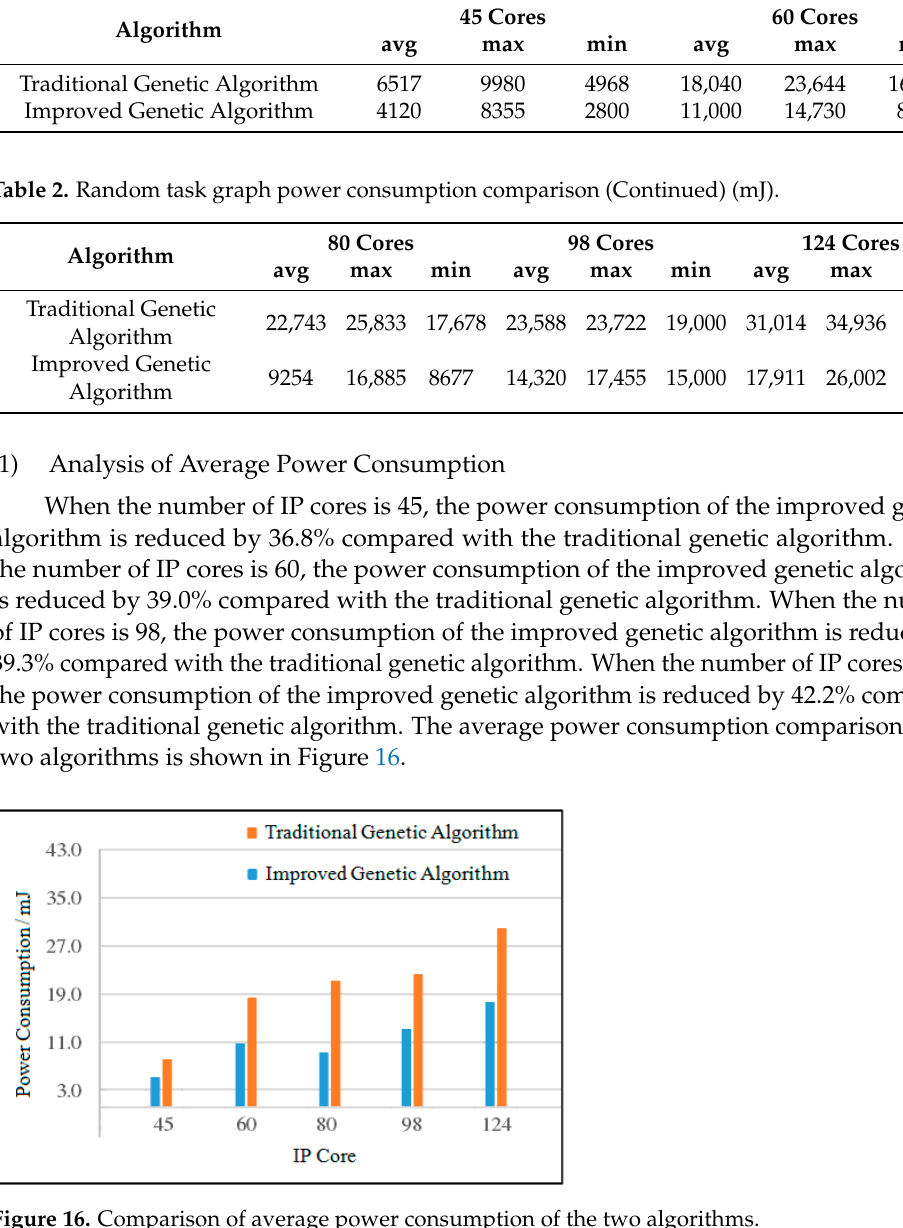
Figure 16. Comparison of average power consumption of the two algorithms.